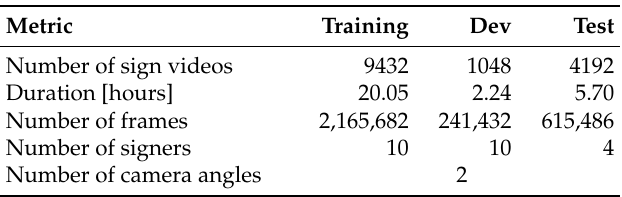
Table 1. Statistics of KETI sign language dataset.